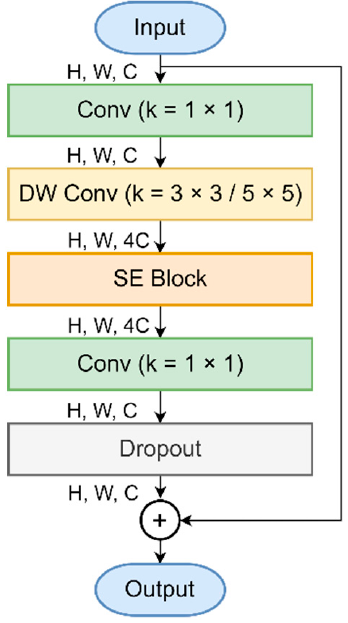
Figure 5. Structure of MBConv block.